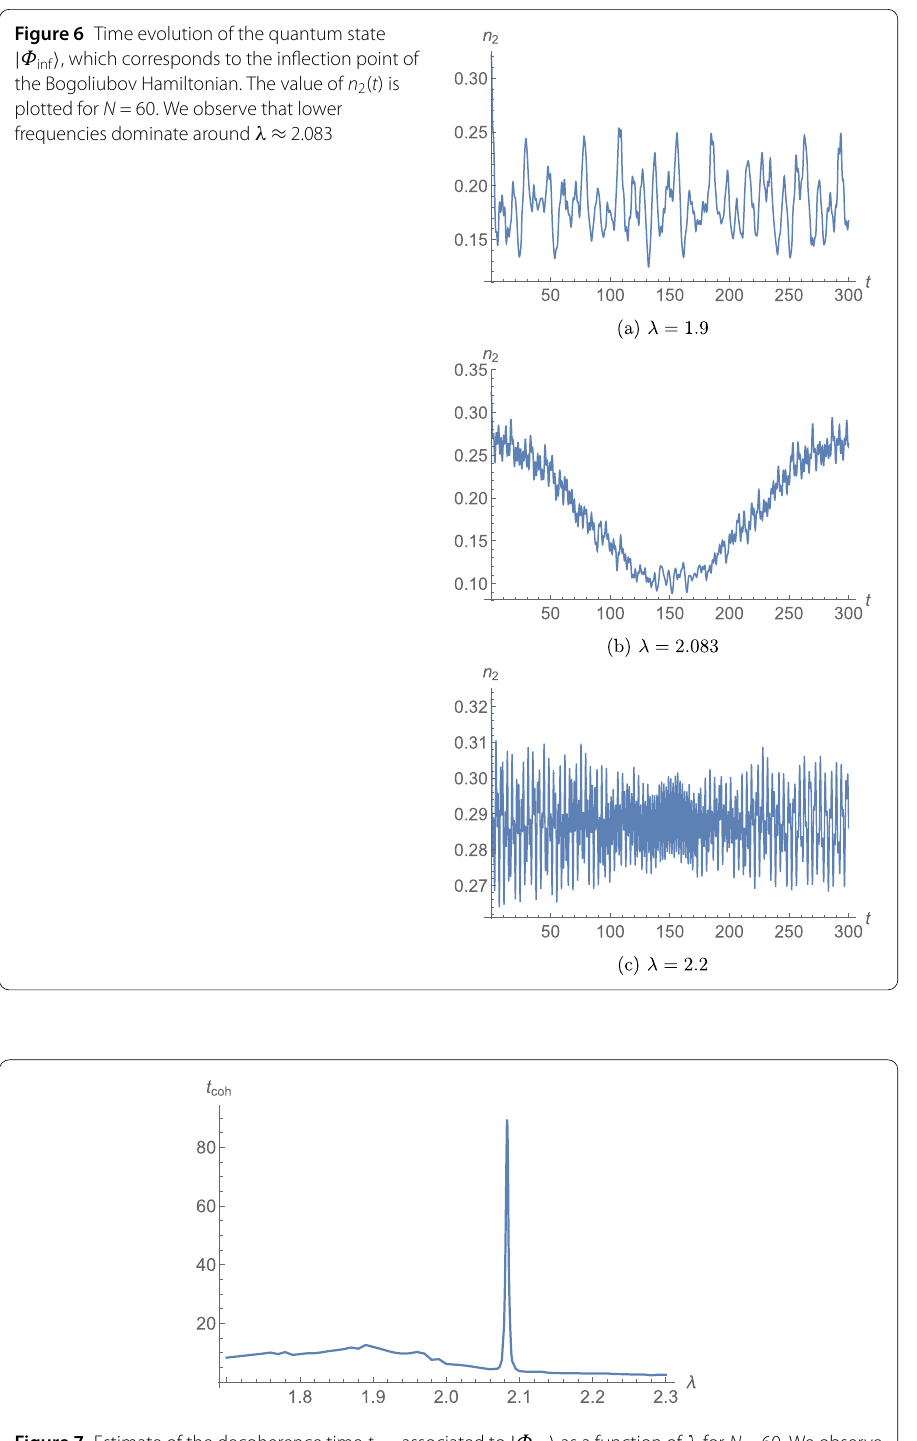
For f 1 = 1/3000 and n max = 12,000, we show t coh as a function of λ in Fig. 7. n We observe that it increases distinctly around λ ≈